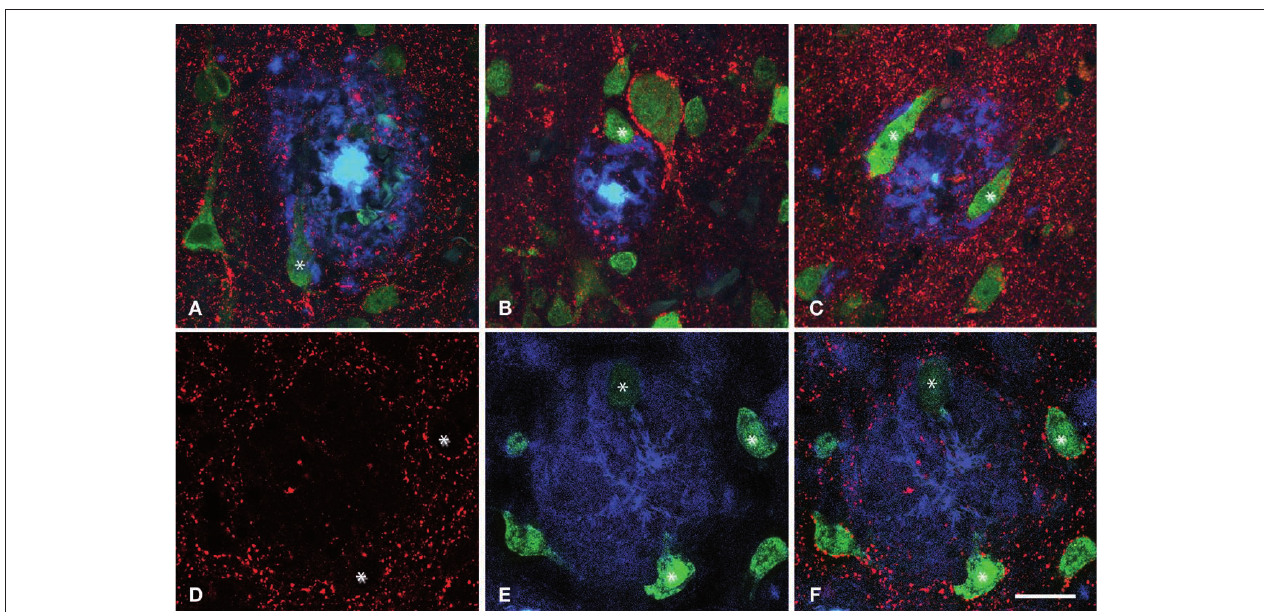
FIGURE 7 | Triple fl uorescence immunohistochemistry to analyze neurons visualized with NeuN (green) in contact (some of them indicated with an asterisk) with plaques labeled with Thiofl avine-S (blue) that were innervated by GABAergic terminals visualized with an antibody against the vesicular GABA transporter (VGAT, red, B and D–F) or GABA transporter 1 (GAT-1, red, A and C). (A–C) , represent stacks of two optical images [10, 15 and 14, 18 steps;